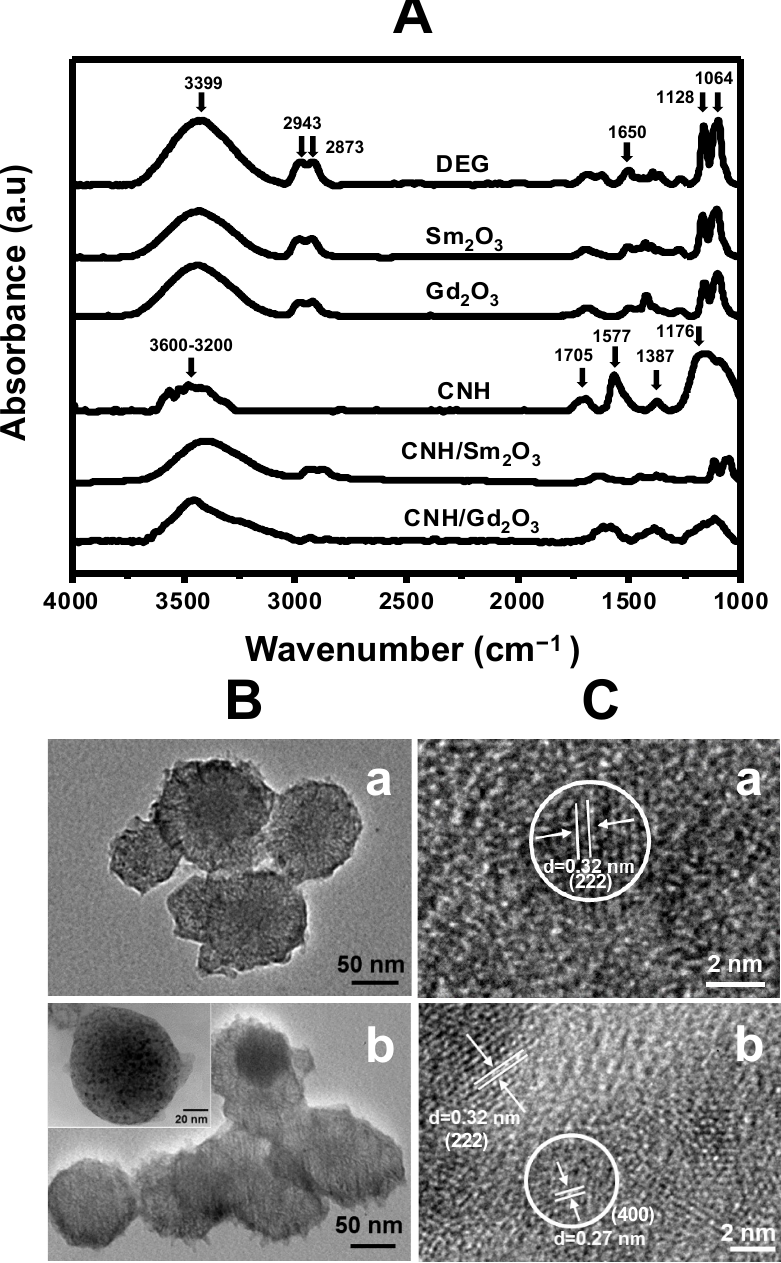
Figure 1. ( A ) FTIR spectra of DEG, Sm 2 O 3, Gd 2 O 3 , CNH, CNH/Sm 2 O 3 , and CNH/Gd 2 O 3 . ( B ) TEM and ( C ) HRTEM images of ( a ) CNH/Gd 2 O 3 and ( b ) CNH/Sm 2 O 3 . Inset in ( B )b shows a higher magnification of CNH/Sm 2 O 3 .